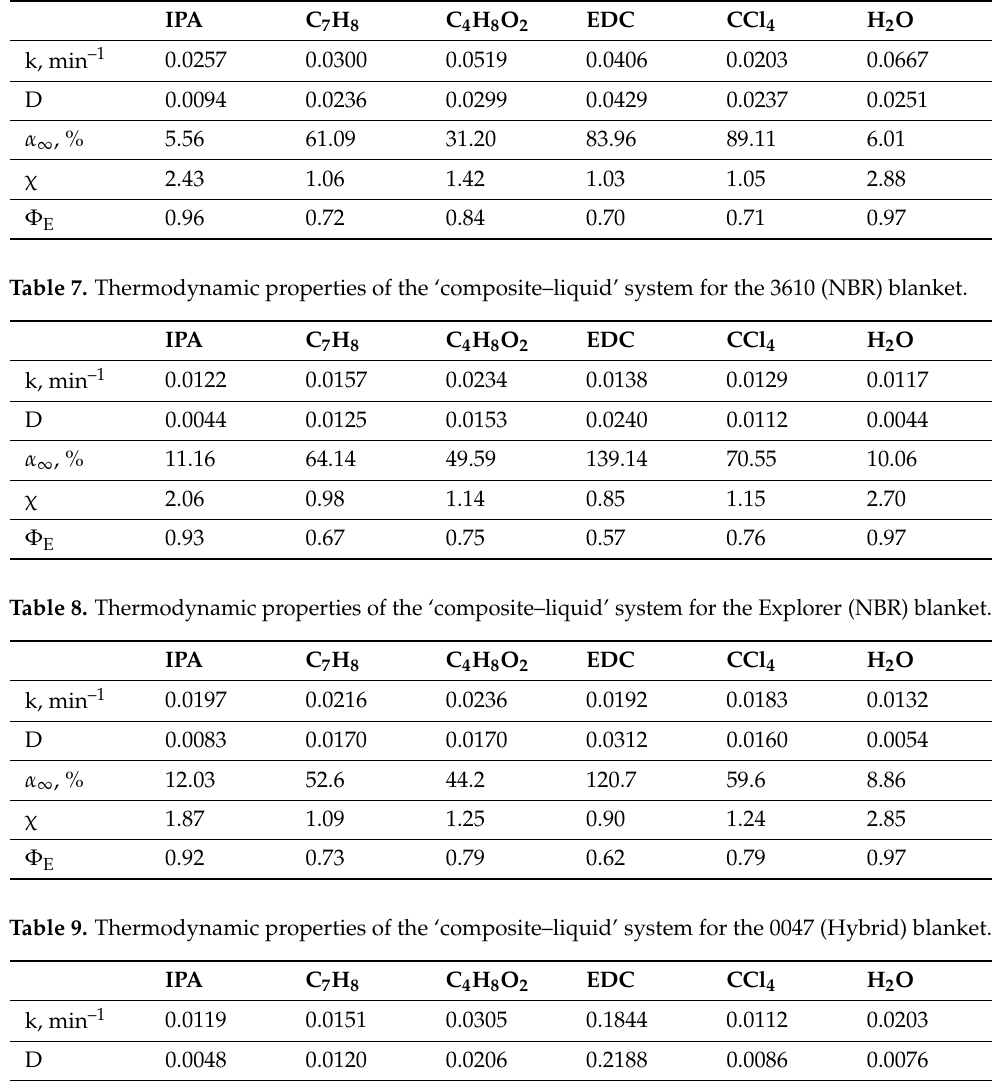
Table 6. Thermodynamic properties of the ‘composite–liquid’ system for the Saphira 1000 (EPDM) blanket.